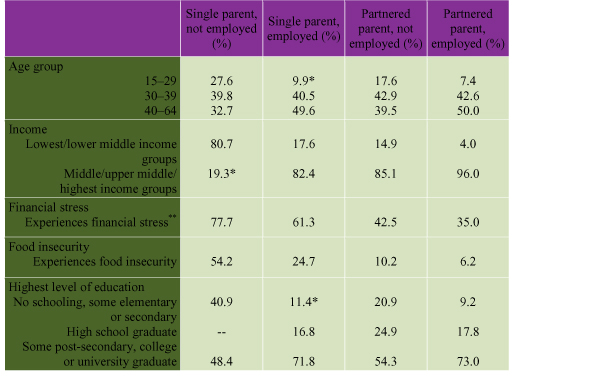
Demographic Characteristics of Women in Role Profiles, Canada, 1998–1999-- Unable to report data (number surveyed is less than 30)  * Coefficient of variation is high (16.6% to 33.3%)